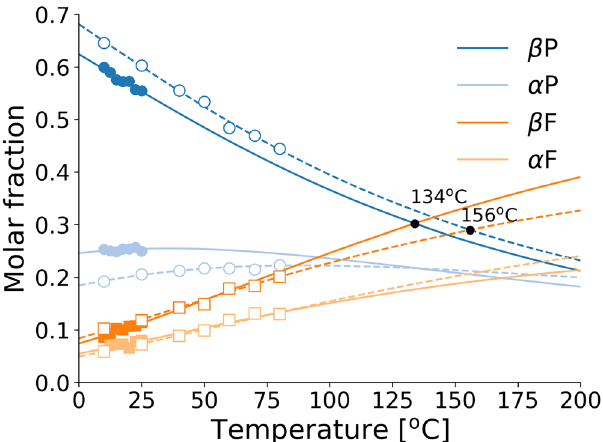
Fig. 2 Population inversions in D-ribose isomerisation network at thermal equilibrium. The average molar fractions of the four main anomers of D- ribose are plotted versus temperature for the experiments performed in pure water (open symbols) and in Hadean model water ( fi lled symbols). Lines are fi ts performed simultaneously with Eq. (2) to the four anomer temperature series (see Table 1). Dashed lines: pure water, solid lines: Hadean model water. In practice, we minimised a single cost function that included a total of 4 N T points, where N T is the number of temperature points considered ( N T = 7 for both pure and Hadean water). Error bars (standard errors on the mean) are smaller than the symbol